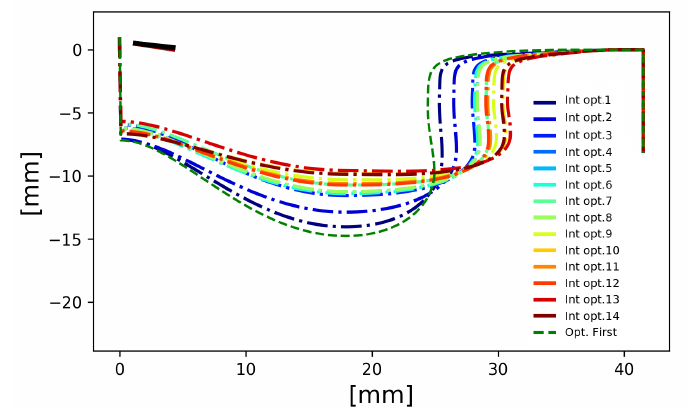
Figure 16. Evolution of the bowl profiles for the best particles of each generation. The fuel stratification at TDC of the baseline, intermediate and final optimum is shown in Figure